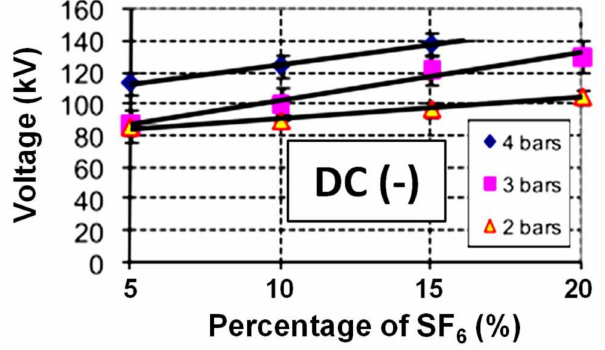
Figure 11. Breakdown voltage of a SF 6 –N 2 mixture at 2, 3, and 4 bar, under negative DC voltage; electrode gap d = 10